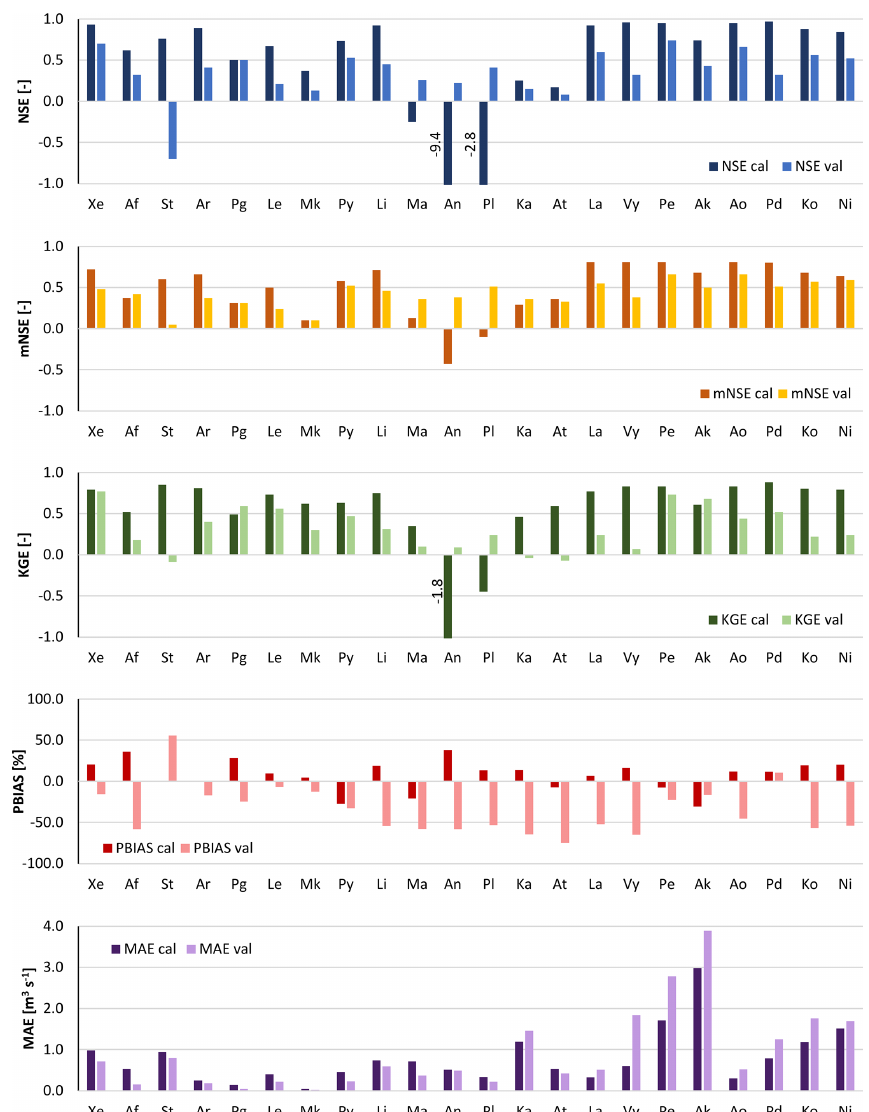
Figure 5. Performance indices (NSE, Nash–Sutcliffe efficiency; mNSE, modified Nash–Sutcliffe efficiency; KGE, Kling–Gupta efficiency; BIAS; MAE, mean absolute error) calculated on daily streamflow resulting from observed rainfall for the 22 watersheds using the calibrated set of parameters for both January 1989 (cal) and November 1994 (val). For watershed abbreviations refer to Table